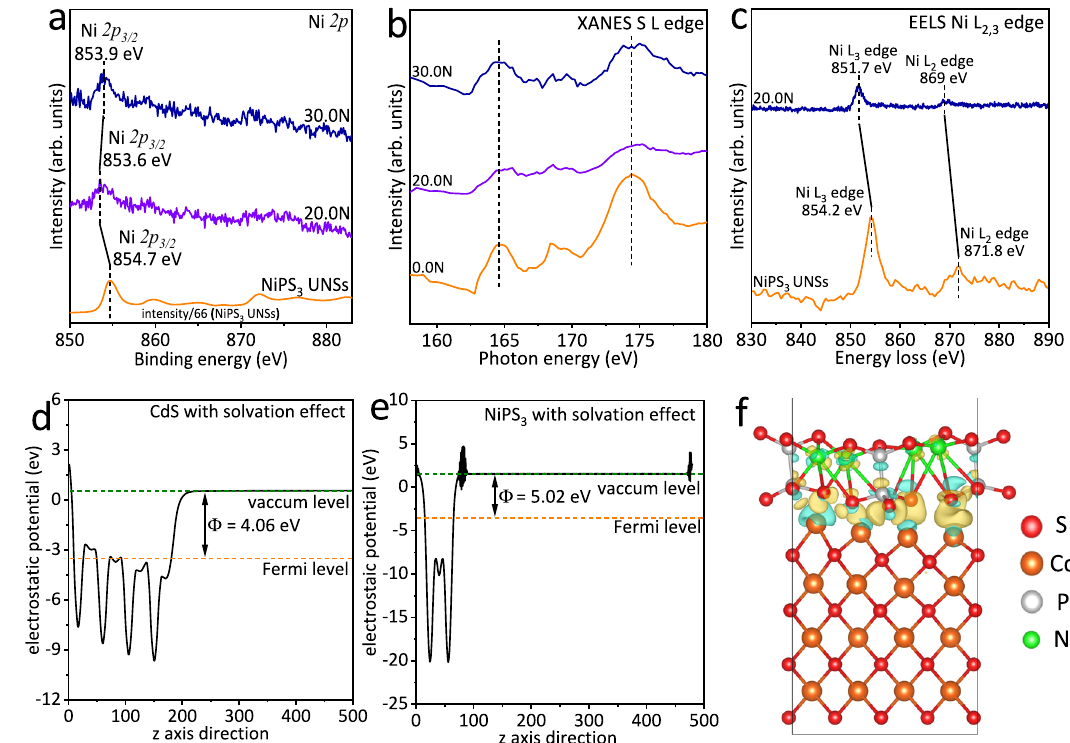
Fig.3|StrongelectronicinteractioninNiPS 3 /CdSsystem.a High-resolutionXPS spectraof Ni 2p for NiPS 3 UNSs, 20.0Nand 30.0N. b Synchrotron-based XANESS L edge of 0.0N, 20.0N and 30.0N. c EELS spectra of Ni L 2,3 edge for NiPS 3 UNSs and 20.0N. Average potential pro fi les along the z axis direction of d CdS (200) crystal facet and e NiPS 3 (002) crystal facet. f The differential charge density map of